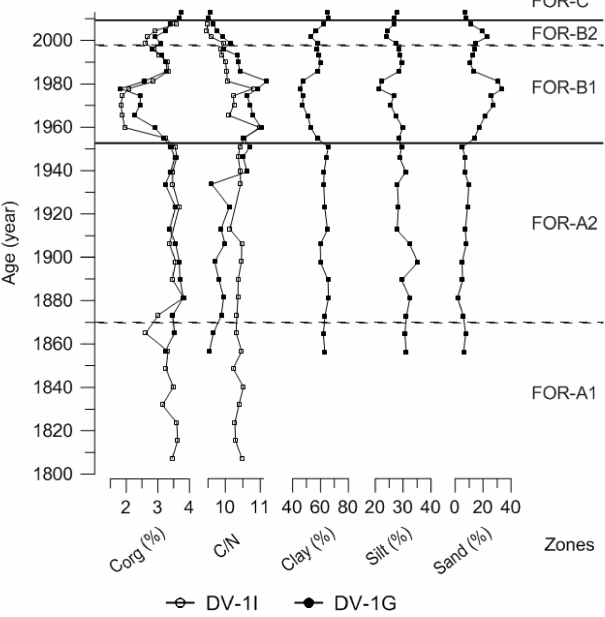
Figure 7. Sediment parameters of cores DV-1I and DV-1G ( 210 Pb dated): total organic carbon content (C org ) (%), C / N ratio, and grain size (%). Foraminiferal zones